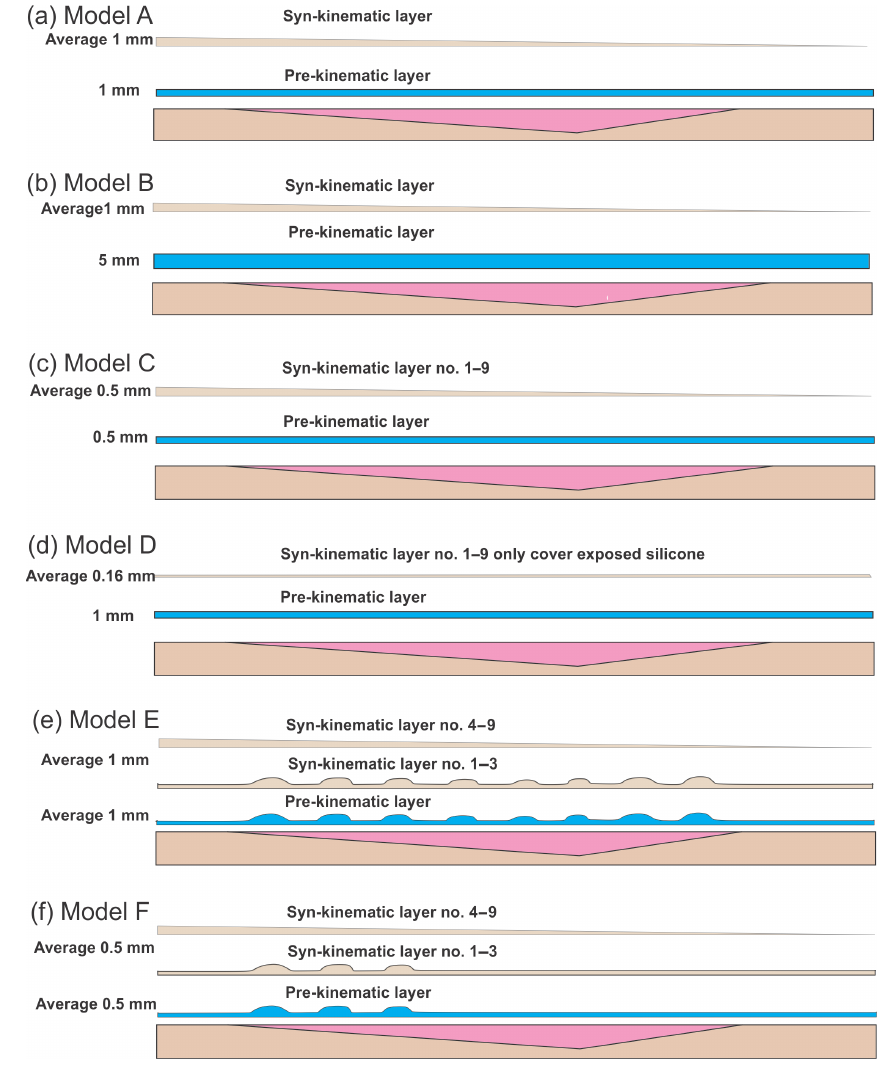
Figure 3. Depositional scenarios for six models of the three experiments. The blue layers are pre-kinematic and brown layers are syn- kinematic. Note the minibasin shapes associated with differential loading in Model E and F. The syn-sedimentation thickness is an average as they are in wedge